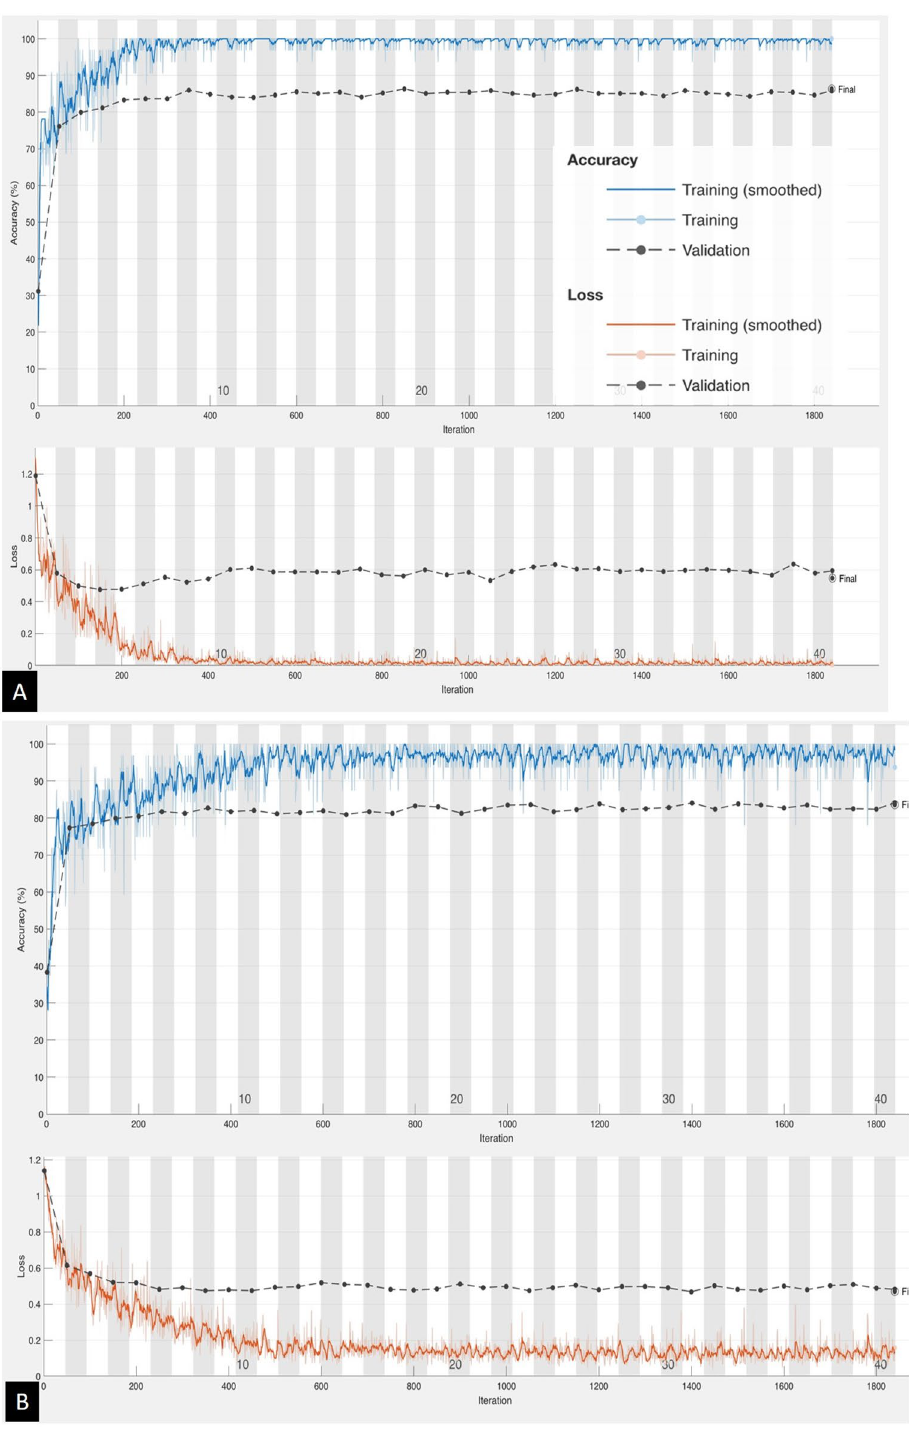
Figure 1. Accuracy and loss graphs of Inception-v3 model ( A ), EfficientNet-b0 model ( B ) and Modified LeNet model ( C